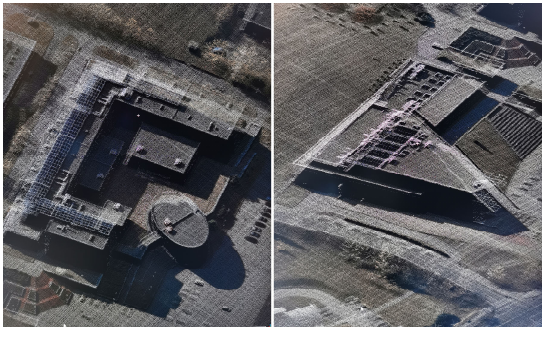
Figure 3. LiDAR point clouds.